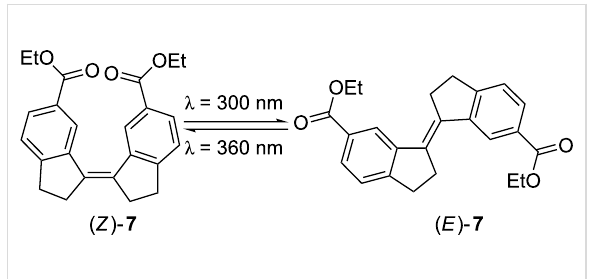
To set the results of this photoisomerization into perspective a noncyclic stiff stilbene was used as a reference (Scheme 4). The photodynamic properties of this compound have been reported previously